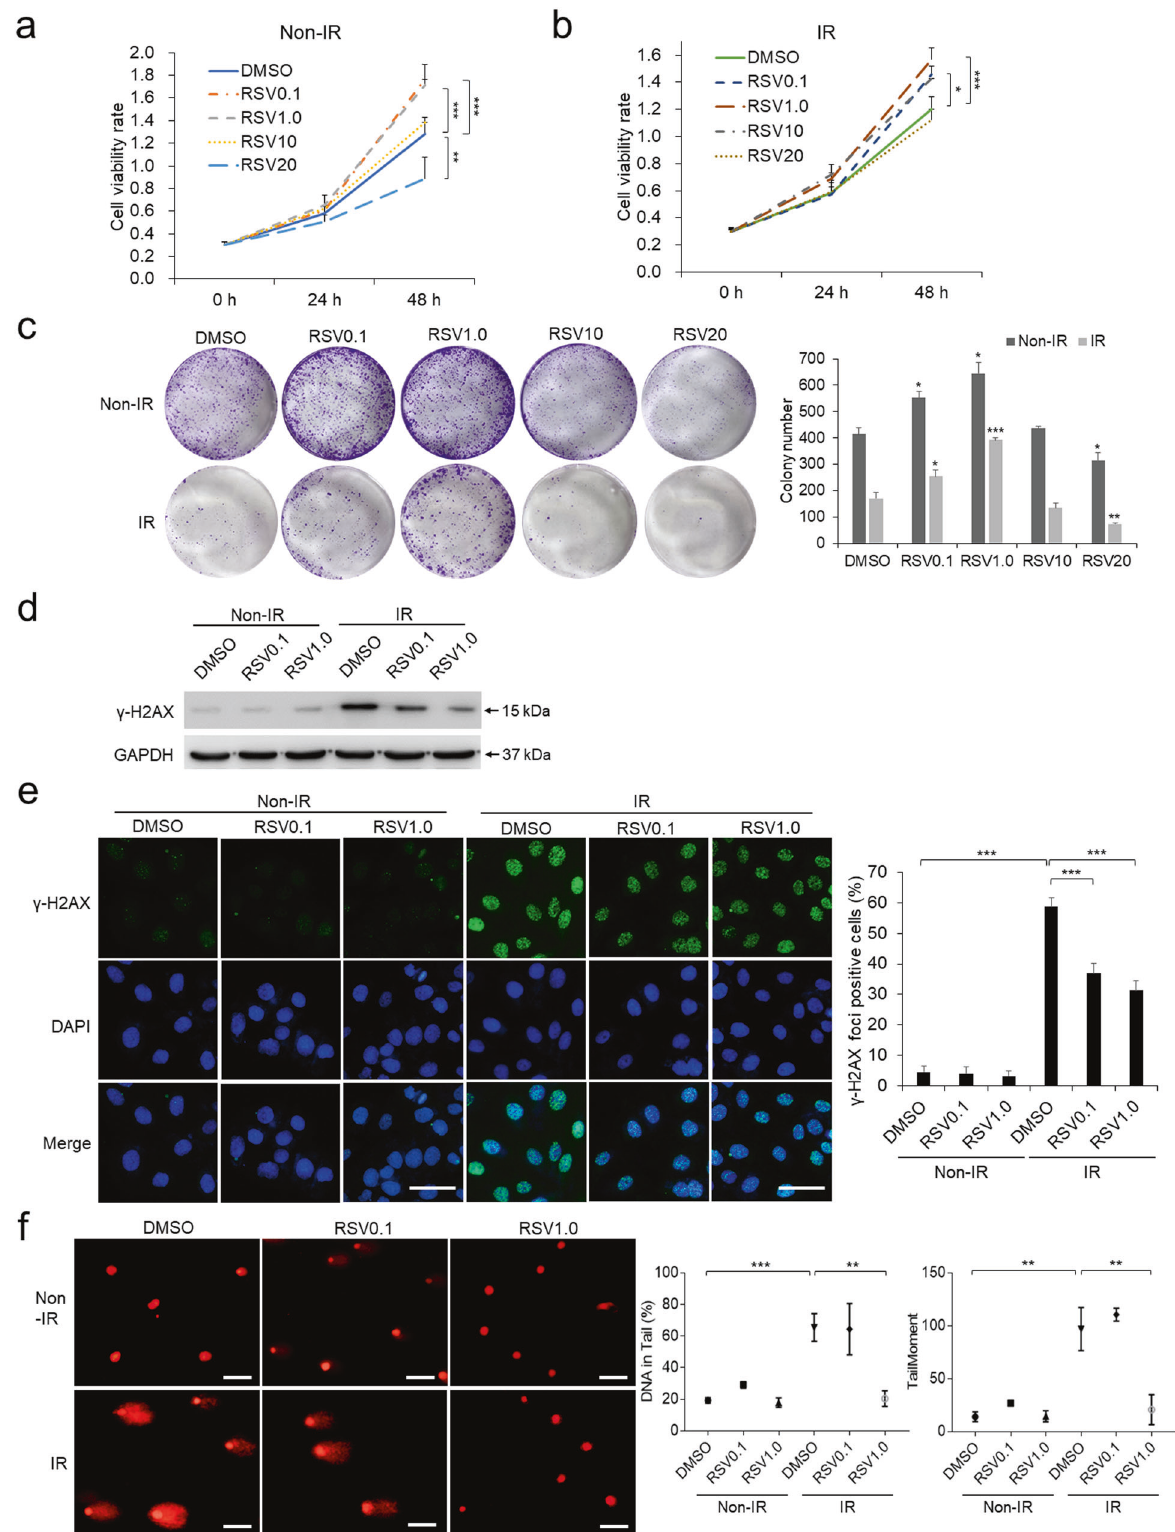
Fig. 1 Resveratrol (RSV) counteracts ionizing radiation (IR)-induced DNA damage in keratinocytes. Measurements of cell viability by CCK-8 assay ( a , b ) and colony formation assay ( c ) were performed in keratinocytes pretreated with DMSO or different concentrations of RSV with control or IR treatments. d Detection of γ -H2AX by Western blot in keratinocytes pretreated with DMSO or different concentrations of RSV with control or IR treatments. e γ -H2AX staining was performed in keratinocytes pretreated with DMSO or different concentrations of RSV with control or IR treatments. γ -H2AX positive cells were count and statistically analyzed. Scale bar: 50 μ m. f Comet assay in keratinocytes pretreated with DMSO or different concentrations of RSV with control or IR treatments. Scale bar: 100 μ m. Each experiment was performed in triplicates and data are presented as mean ± s.d. * p < 0.05, ** p < 0.01, *** p < 0.001. Cell Death and Disease (2022)